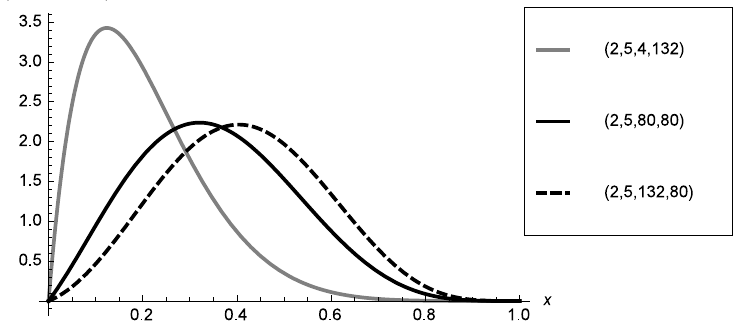
Figure 9 { Plots of the density of X ′′ (cid:24) CDNCB ( (cid:11) 1 ; (cid:11) 2 ; (cid:21) 1 ; (cid:21) 2 ) for selected values of ( (cid:11) 1 ; (cid:11) 2 ; (cid:21) 1 ; (cid:21) 2 ).